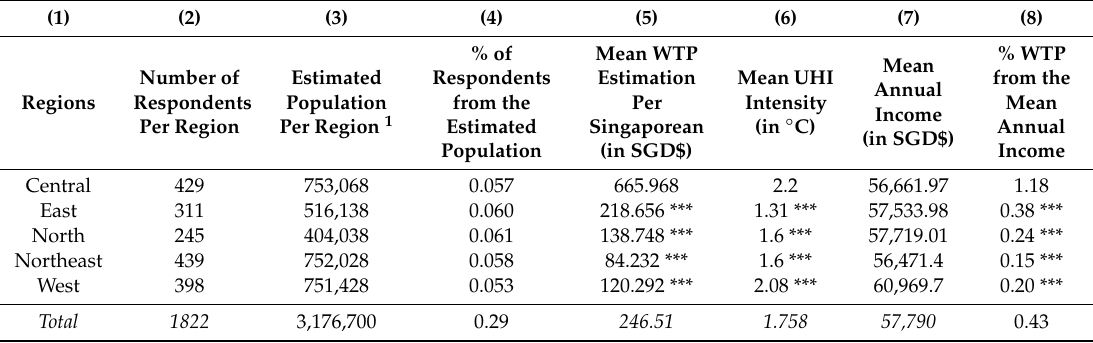
Table 5. Mean WTP, UHI intensity, and mean annual personal income per